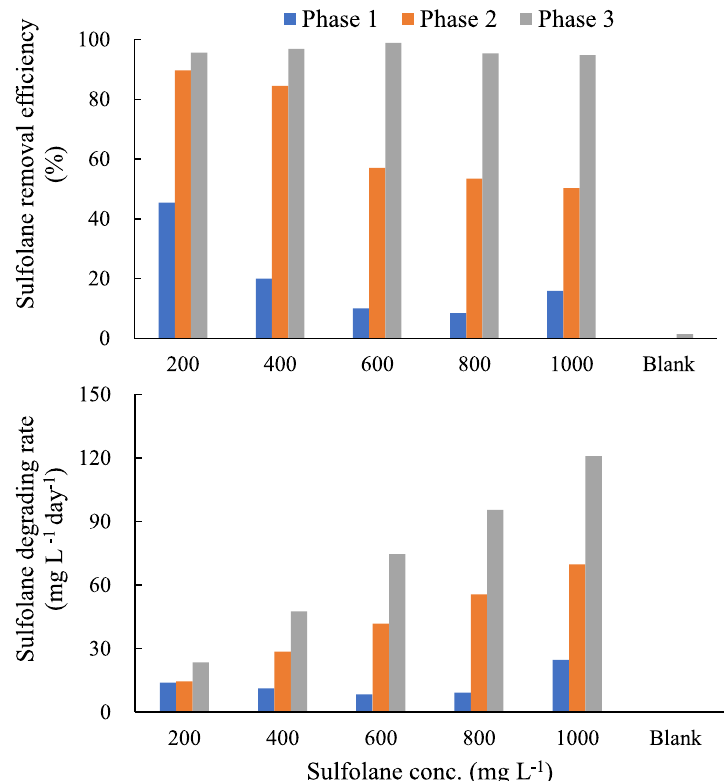
Fig. 1 Sulfolane removal efficiency and degrading rate of three enrichment phases (Phase I: Day 1–48; Phase II: Day 49–62; Phase II: Day 63–70) on the 7 th